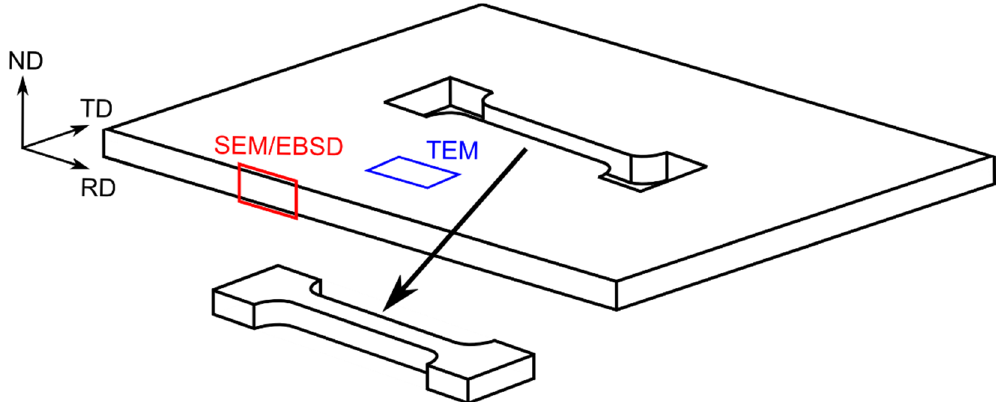
Figure 1. Scheme of cutting samples from Zn-Cu sheets for uniaxial tensile test and depicted cross-section of EBSD and TEM